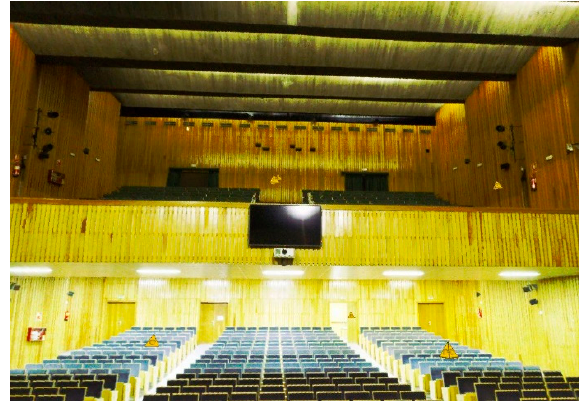
Figure 14. Internal data capture of the assembly hall of Civil Engineering School (ETSICCP) at Universidad Politécnica de Madrid (UPM).